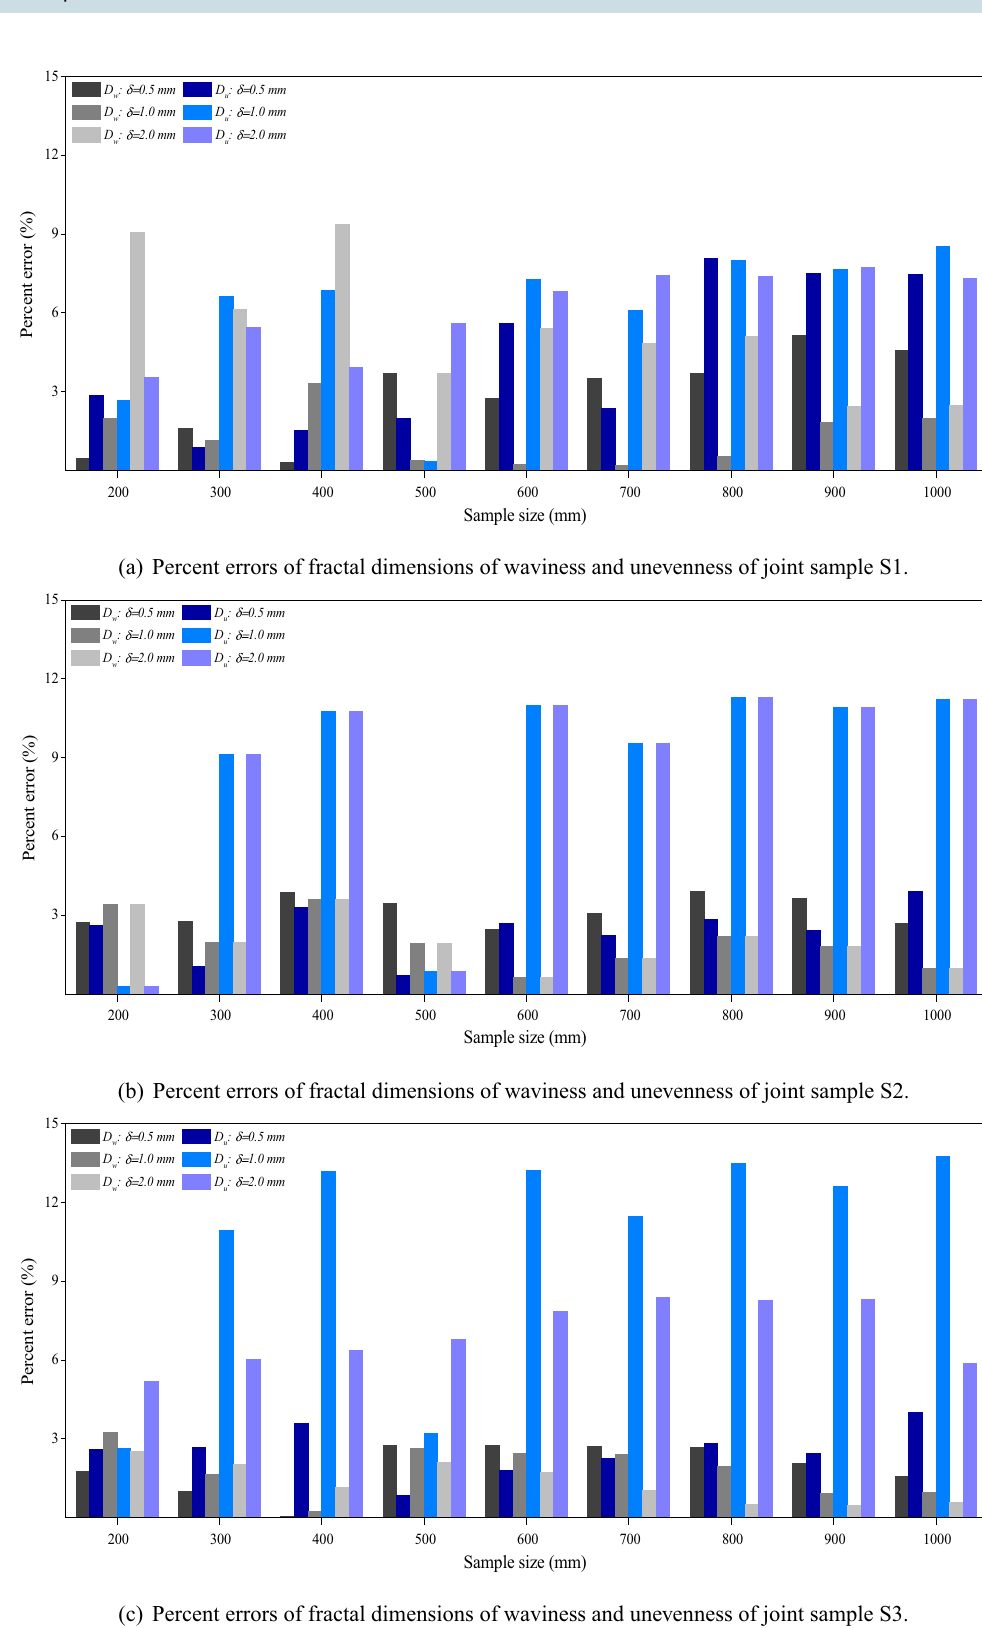
Figure 11. Effect of sample size on the fractal dimensions of waviness and unevenness of three rock joints of three resolutions. Percent errors are relative to the values of window size of 100 mm × 100 mm. D w and D u are fractal dimensions of waviness and unevenness. δ denotes the